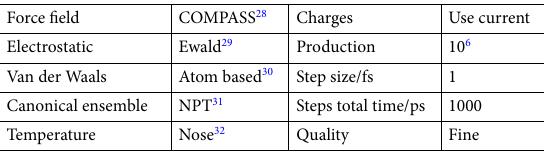
Table 1. Parameters of molecular dynamics.